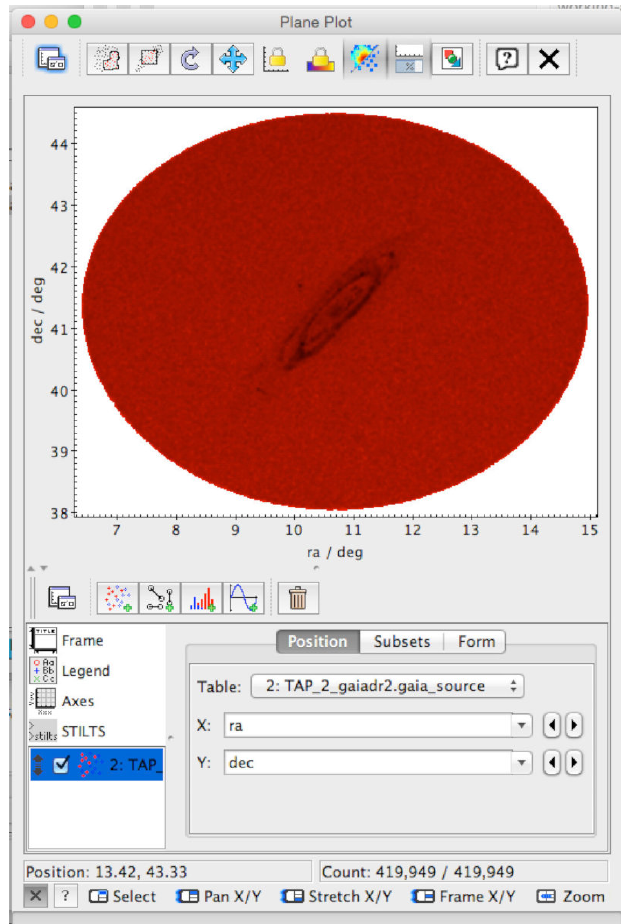
Fig. 59.— A plane plot of the Andromeda galaxy, based on Gaia DR2 cending order (ASC; descending order would be DESC).